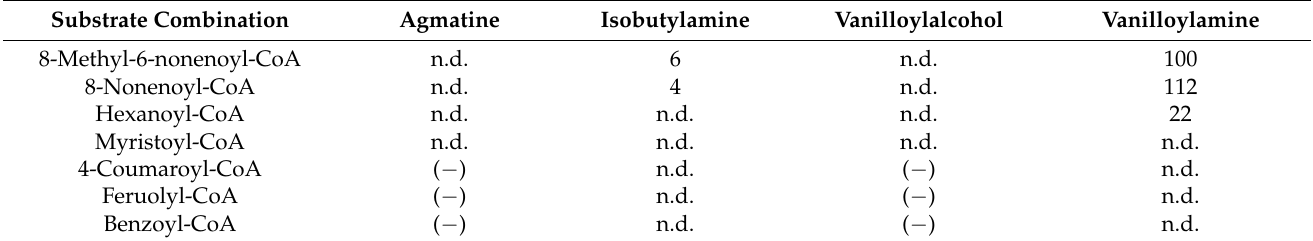
Table 2. Matrix of the substrate specificity of recombinant capsaicin synthase. The activity of the partially purified enzyme was calculated to the 240 nkat mg − 1 protein and set to 100% (measured as the average of 3 technical replicates). Relative values are calculated in the case of other substrates (n.d. = product formation not detectable; ( − ) = not